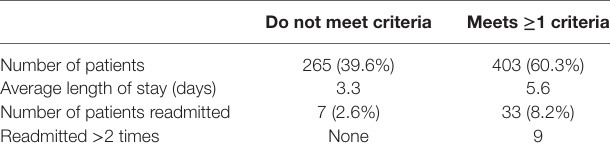
taBLe 2 | Comparison of characteristics of patients who are eligible for palliative care to those who are not based on the Angkor Hospital for Children 2012 first quarter